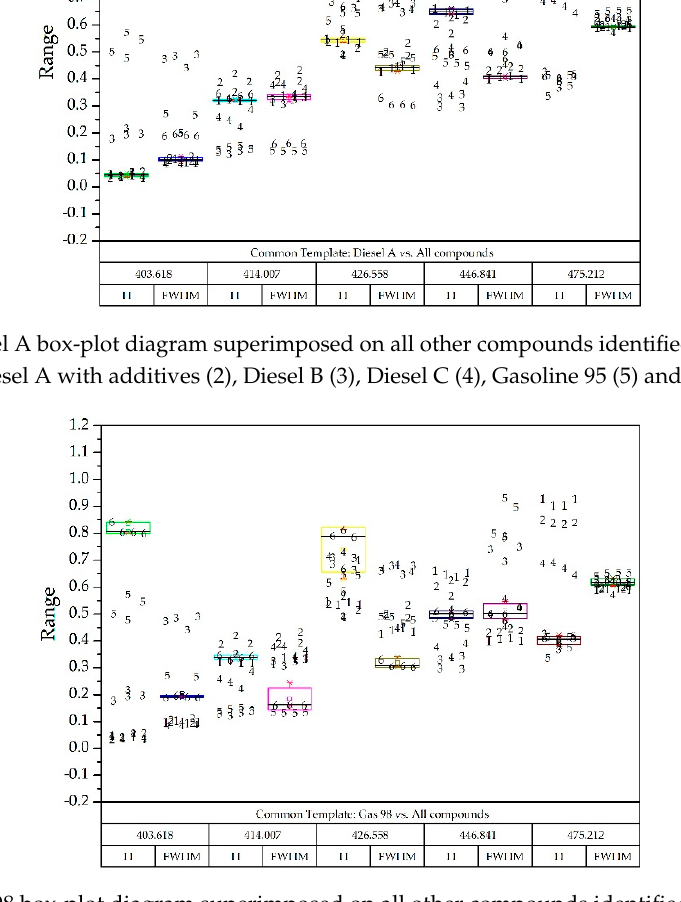
Figure 13. Gas 98 box-plot diagram superimposed on all other compounds identified with numbers: Diesel A (1), Diesel A with additives (2), Diesel B (3), Diesel C (4), Gasoline 95 (5) and Gasoline 98 (6).